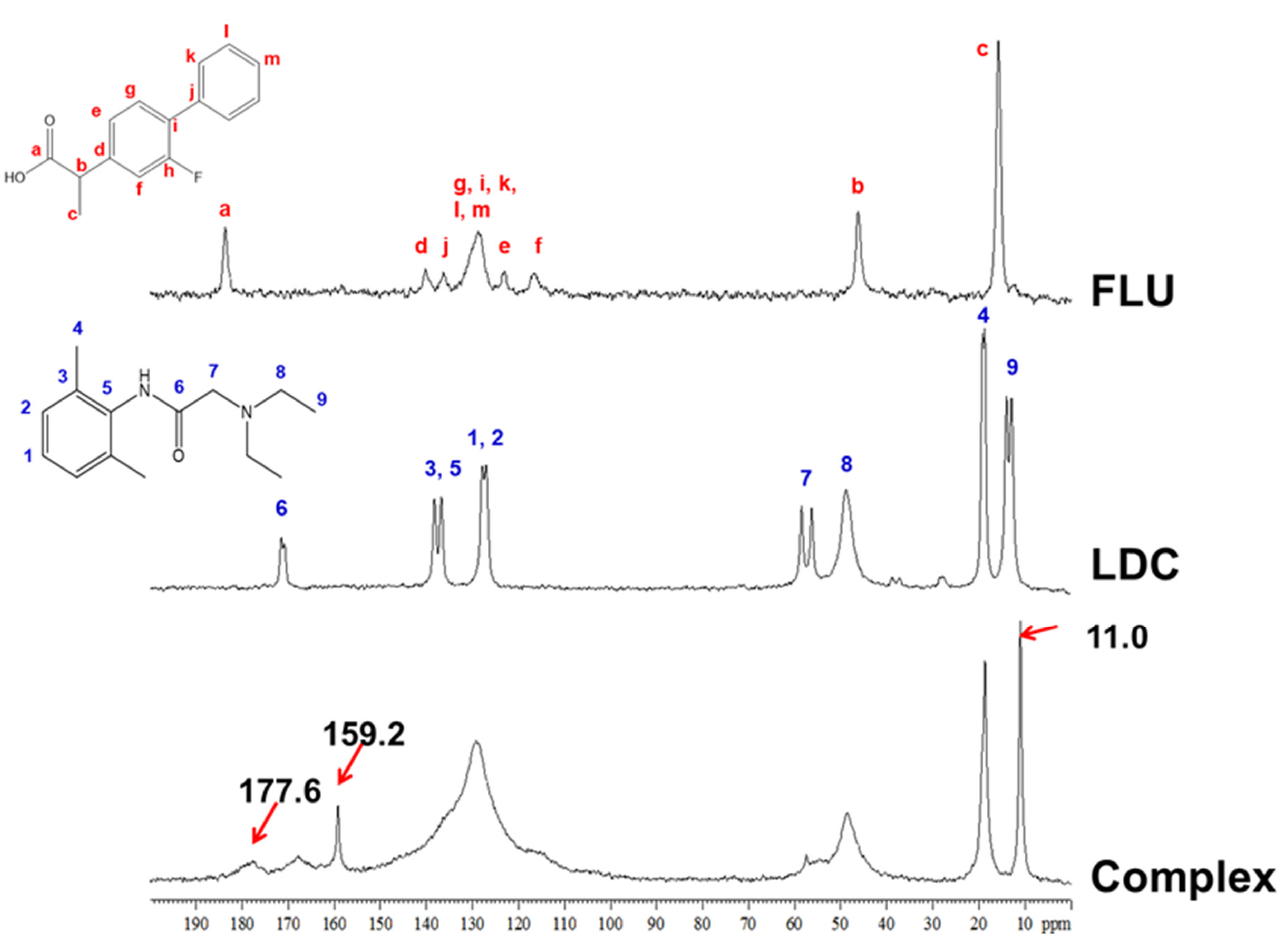
Figure 4. 13 C DD/MAS NMR spectra of FLU, LDC, and FLU/LDC complex.